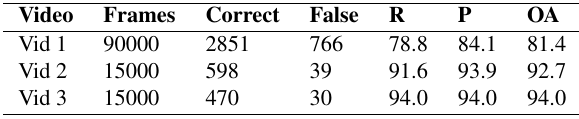
Table 4: Validation of classification in terms of quality of the video